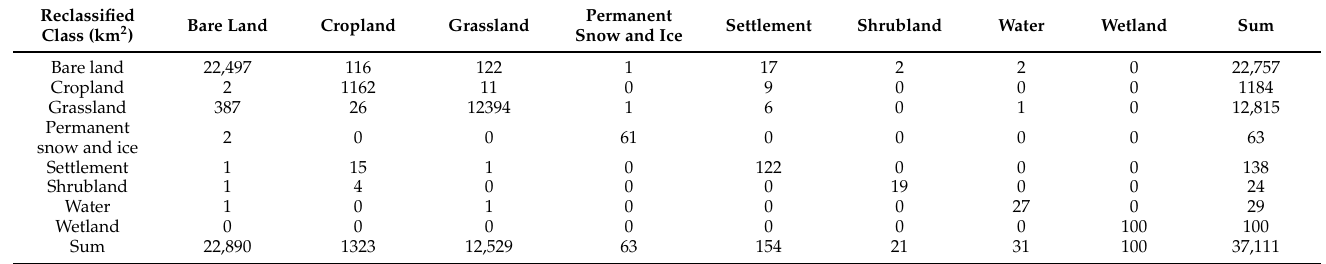
Table A3. Land use/land cover area transfer matrix from the year 2000 to 2010 in the Turpan Basin.